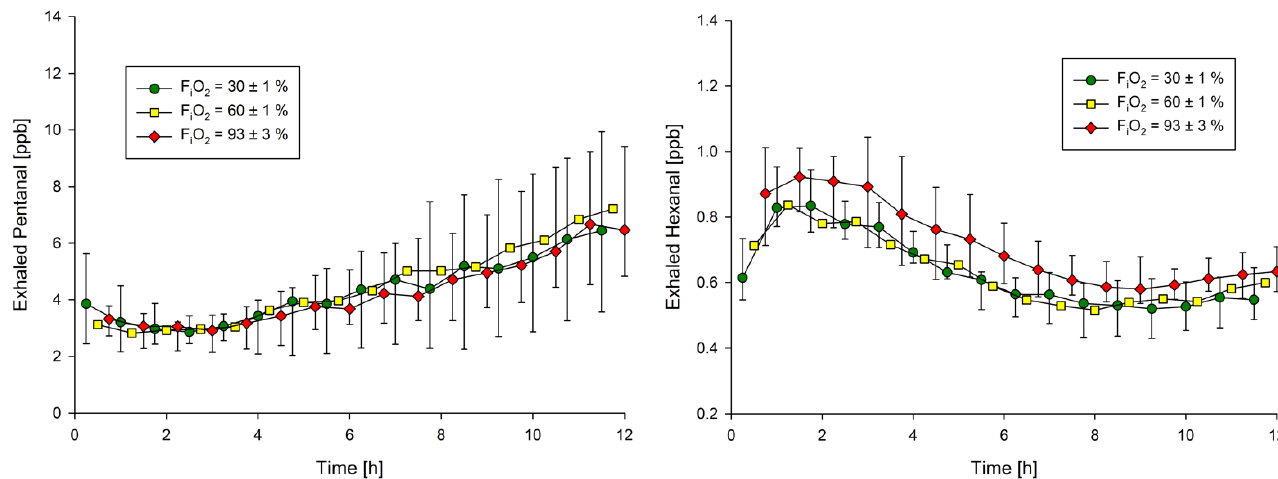
Figure 2. Pentanal and hexanal exhalation over 12 h of mechanical ventilation. Data presented as medians and interquartile ranges. F i O 2 = fraction of inspired oxygen. Exhaled concentrations were measured at 15-minute intervals, with every third value displayed and error bars omitted for 60% to enhance clarity.